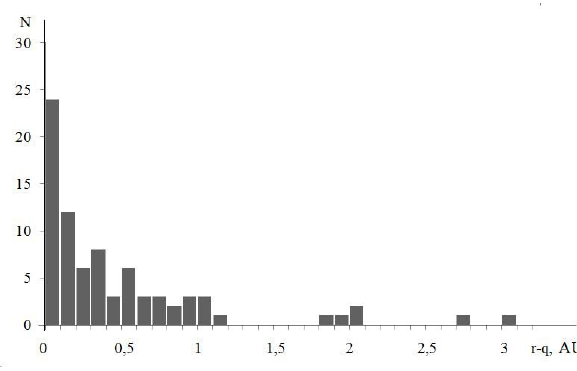
Figure 6. Dependence of the number of comets N with an anoma- lous tail on ( r - q